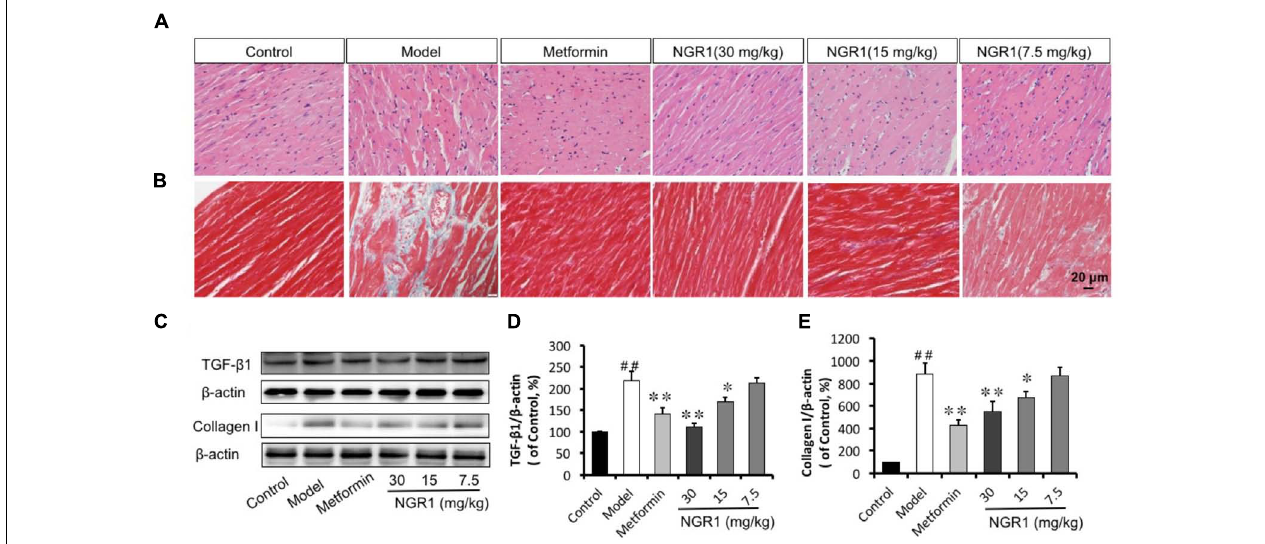
FIGURE 6 | NGR1 attenuates diabetes-induced cardiac pathological alterations. (A,B) Reversal of diabetes-induced-cardiac hypertrophy and fibrosis by NGR1 as indicated by H&E and Masson staining (400 × ). (C) Representative images and bar graphs of TGF β 1 (D) and Collagen I (E) by western blot showed that NGR1 suppressed cardiac fibrosis. The quantitative data are presented as the mean ± SD ( n = 3). ## P < 0.01 vs. the Control group, ∗ P < 0.05 or ∗∗ P < 0.01 vs. the Model